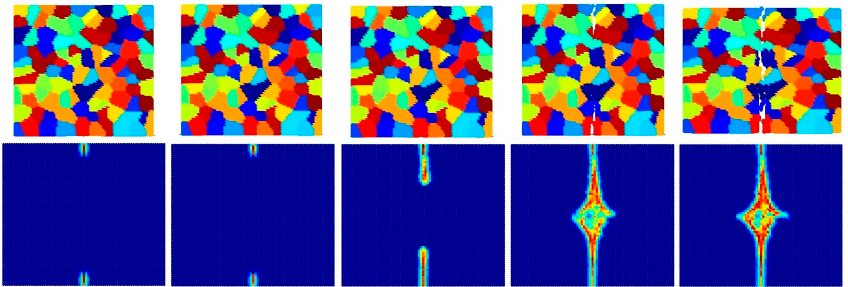
Figure 17. Fracture pattern of polycrystal when β = 1.0 with 74 × 74 particles. From left to right: time = 1.5 μ s, 2.0 μ s, 2.5 μ s, 3.0 μ s, and 3.5 μ s, respectively.